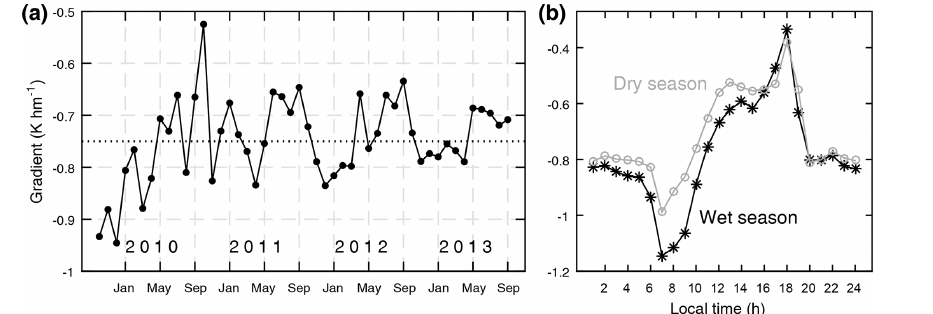
Figure 5. (a) Mean monthly T gradient (dotted line indicates the 4-year mean) and (b) its mean diurnal cycle for the climatological dry (JF, JJAS) and wet (MAM, OND) seasons in grey and black, respectively, between 8 October 2009 and 30 September 2013. Note the different y -axis scaling.